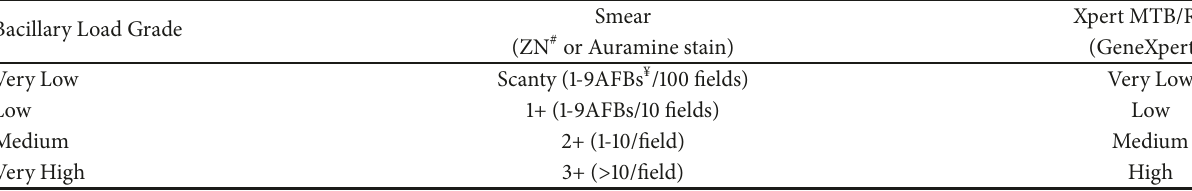
Table 1: Grading of bacillary load by laboratory